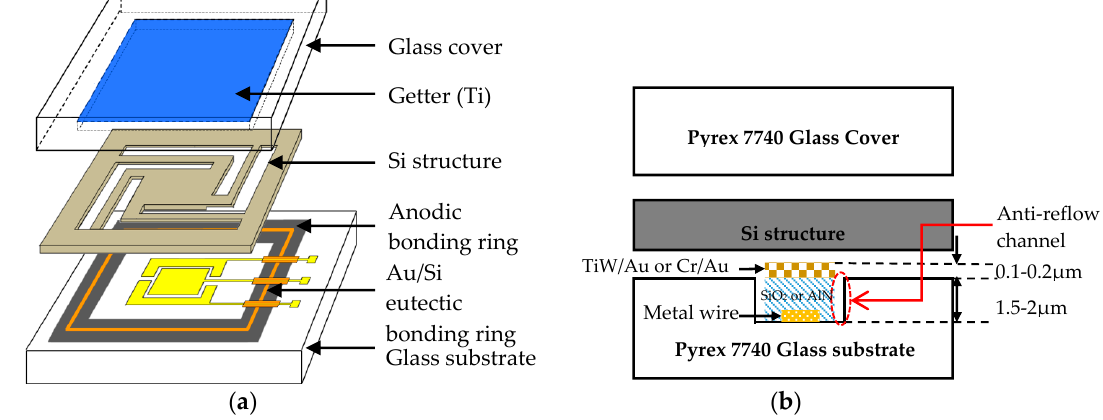
Figure 9. Schematic diagram of wafer-level vacuum packaging for an MEMS accelerometer. ( a ) 3D structure of packaged MEMS accelerometer; ( b ) a cross-sectional diagram of accelerometer observing from the metal wire section.